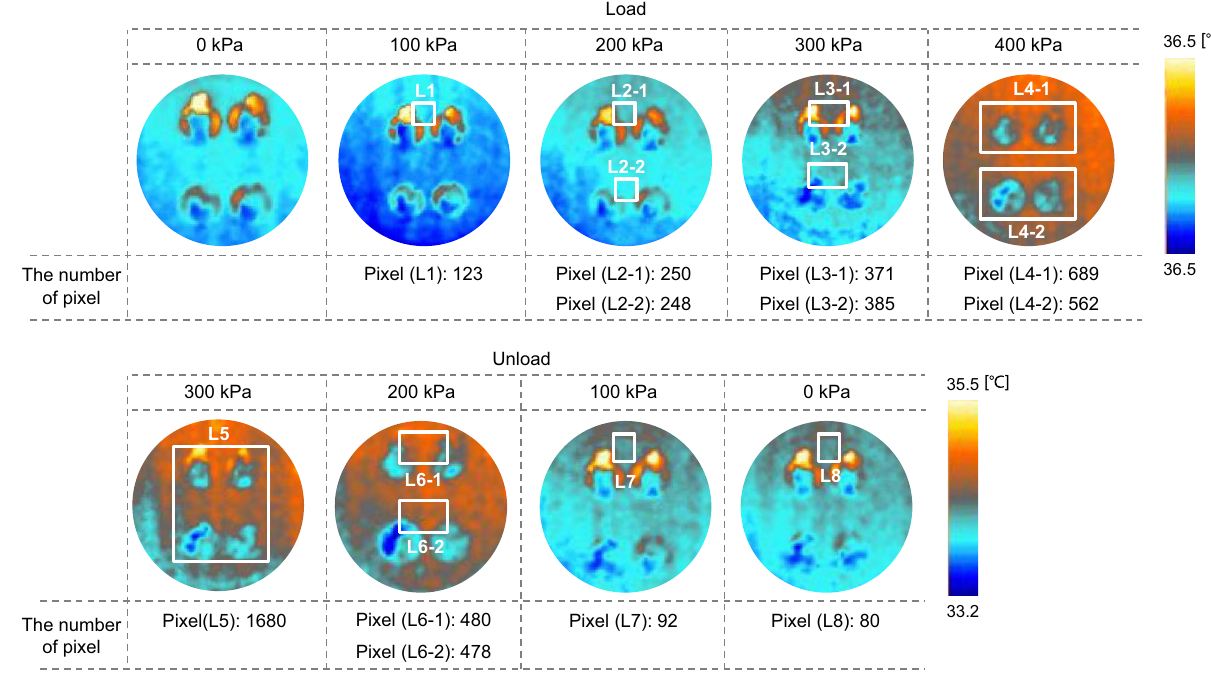
Figure 11. Thermal images measured by the passive method. The white box denotes the area of significant variation.